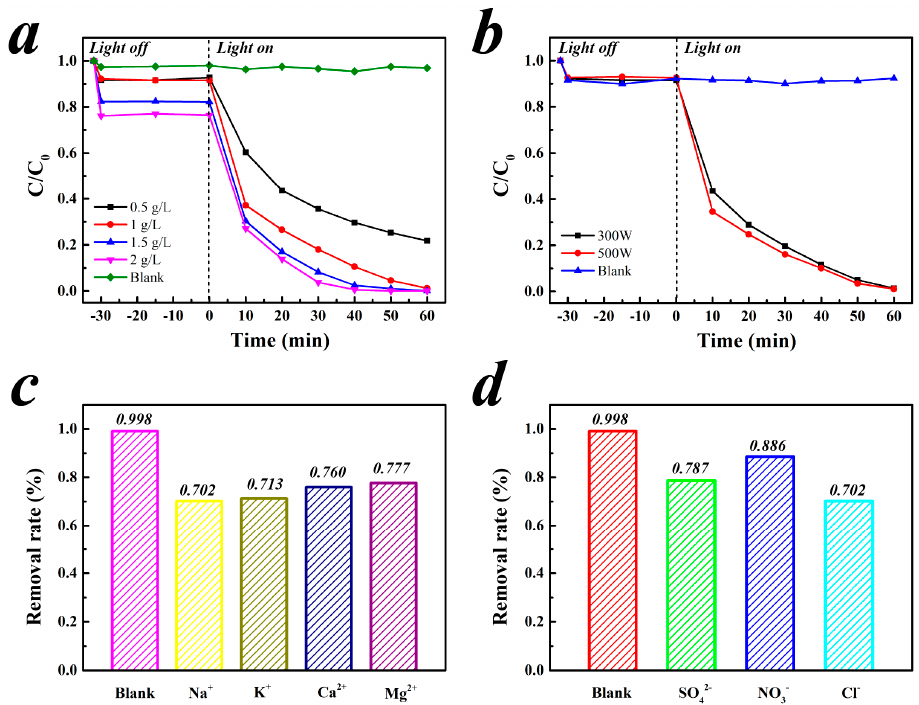
Figure 5. ( a ) Photocatalytic redaction of Cr(VI) by Ag@TiO 2 composites of various dosages (the blank sample catalytic system showed that no obvious Cr(VI) degradation could be observed under UV irradiation); ( b ) Effect of illumination on Cr(VI) reduction; ( c ) Removal rate of co-existing cations on Cr(VI) reduction efficiency (metal salts:, NaCl, KCl, MgCl 2 , CaCl 2 ; ( d ) Removal rate of co-existing